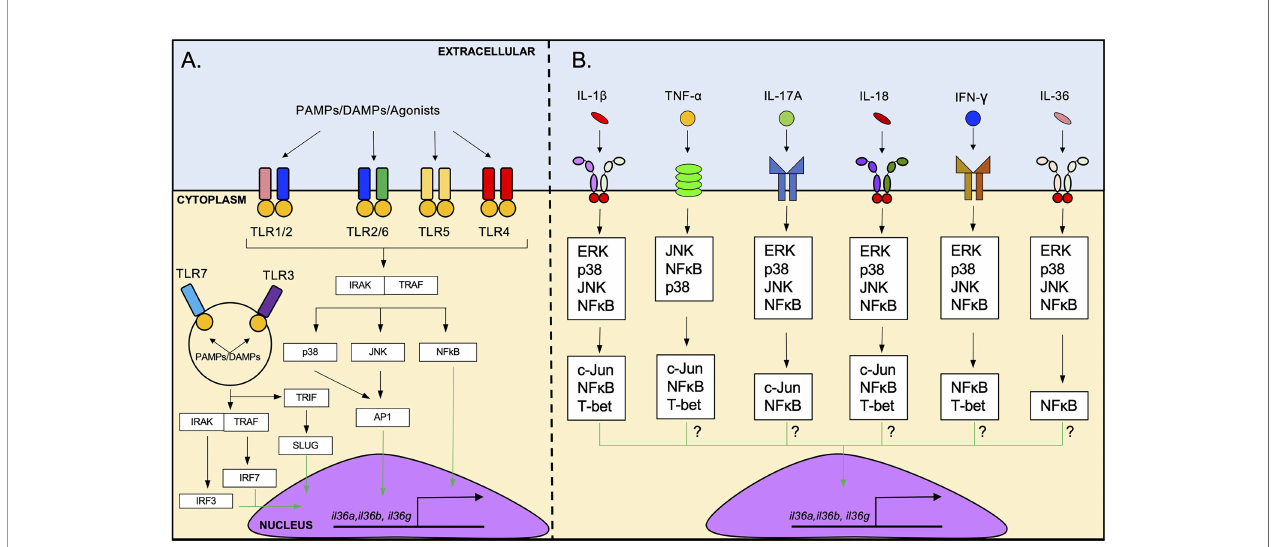
FIGURE 2 | Induction of IL-36 cytokine expression by TLR agonists and pro-in fl ammatory cytokines. (A) il36 transcription is triggered by the activation of several cell surface TLRs such as TLR1/2, TLR2/6, TLR5 and TLR4. The possible intracellular pathway that induces il36 transcription downstream of TLRs activation involves signaling via IRAK/TRAF and p38/JNK/NF k B, followed by the translocation of AP1 and NF k B to the nucleus. Intracellular TLRs such as TLR3 and TLR7 can also induce il36 transcription. These receptors can activate IRF3/7 which may induce the transcription of il36 . (B) il36 expression is induced by several pro-in fl ammatory cytokines such as IL-1 b , TNF- a , IL-17A, IL-18, IFN- g and IL-36 cytokines. IL-1 b -mediated induction of il36 expression via IL1R-IL1AcP involves the ERK/p38/JNK/ NF k B signaling and subsequent activation of the transcription factors c-Jun, T-bet and NF k B. The exact pathway via which other cytokines induce il36 transcription has not been determined yet but likely involves similar intracellular signaling